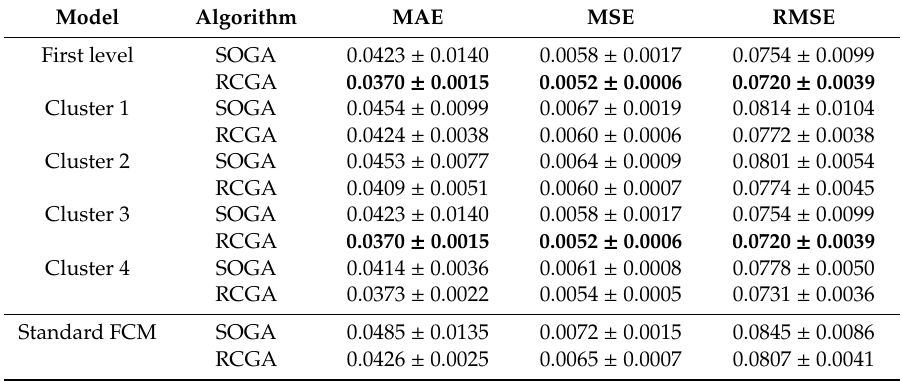
Table 2. Comparison results among the nested fuzzy cognitive map and standard fuzzy cognitive